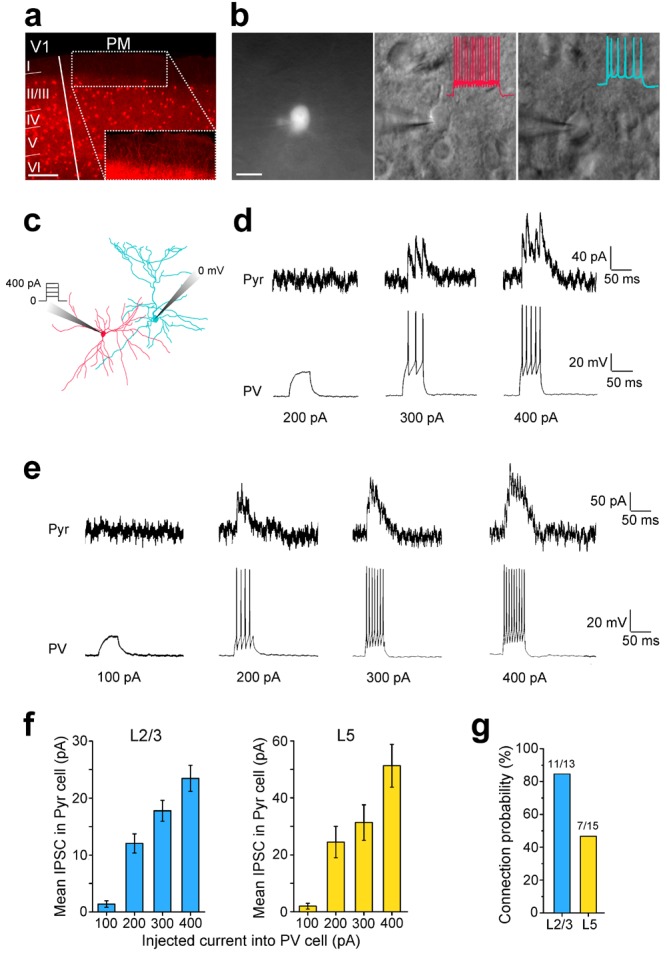
Paired recordings of excitation-dependent, PV cell-mediated inhibition of Pyr cells.(a) Coronal section through V1 and PM of a PV-Cre × Ai9 mouse in which PV cells express tdT (red). Scale bar, 200 µm. Inset: Higher magnification of the boxed region shows a high density of tdT-expressing dendrites in L1 even though PV cell bodies are not found in this layer. (b) Left, PV cell identified by tdT expression targeted for whole-cell recordings. Scale bar, 20 µm. Middle, same cell as in left panel, imaged under DIC-IR optics. PV cell shows a non-adapting, fast-spiking firing pattern (inset, red trace) upon current injection. Right, A Pyr cell under infrared optics exhibits an adapting spiking physiology (blue trace) upon current injection. (c) Schematic of paired recordings of a PV (red) and a Pyr (blue) cell. Successively increasing current steps (100, 200, 300 and 400 pA) were injected into the PV cell under current clamp, and inhibitory currents (IPSCs) were recorded in the Pyr cell held at 0 mV under voltage clamp. (d) Example trace in a L2/3 PV-Pyr connected pair in PM. Increasing current injections into the PV cell results in stronger inhibitory drive to the Pyr cell. (e) Example traces of a connected PV-Pyr cell pair in L5 of PM. (f) Pooled data from connected PV-Pyr pairs in L2/3 (left) and L5 (right) show that increasing the excitation of PV cells results in stronger inhibition of synaptically connected Pyr cells (p<0.001 for both sets of data; ANOVA). Mean IPSCs measured over 75 ms after start of current step. (g) Probability of a PV cell connected to a neighboring Pyr cell (<100 µm) in L2/3 and L5 of PM.